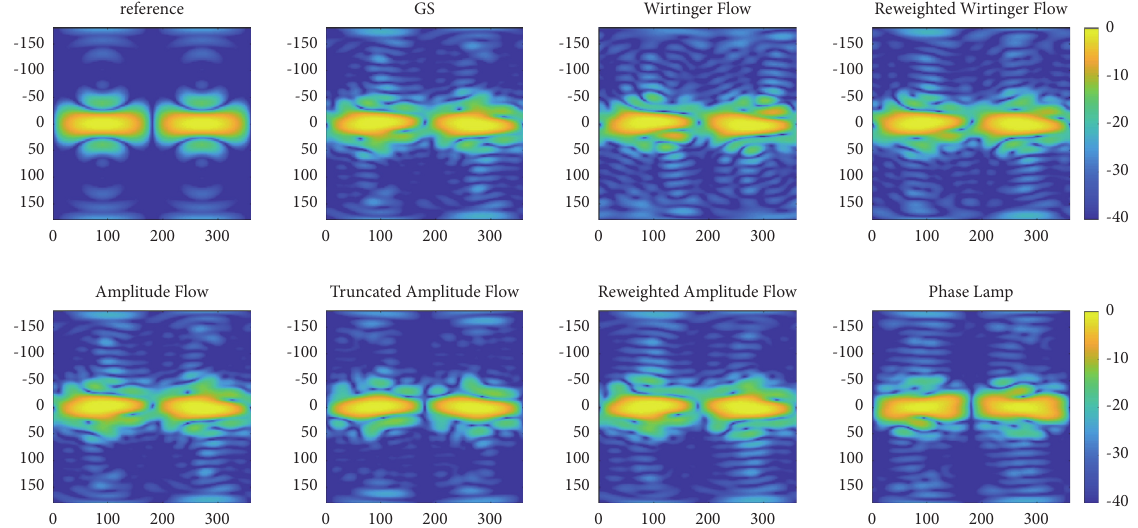
Figure 11: The reconstructed E